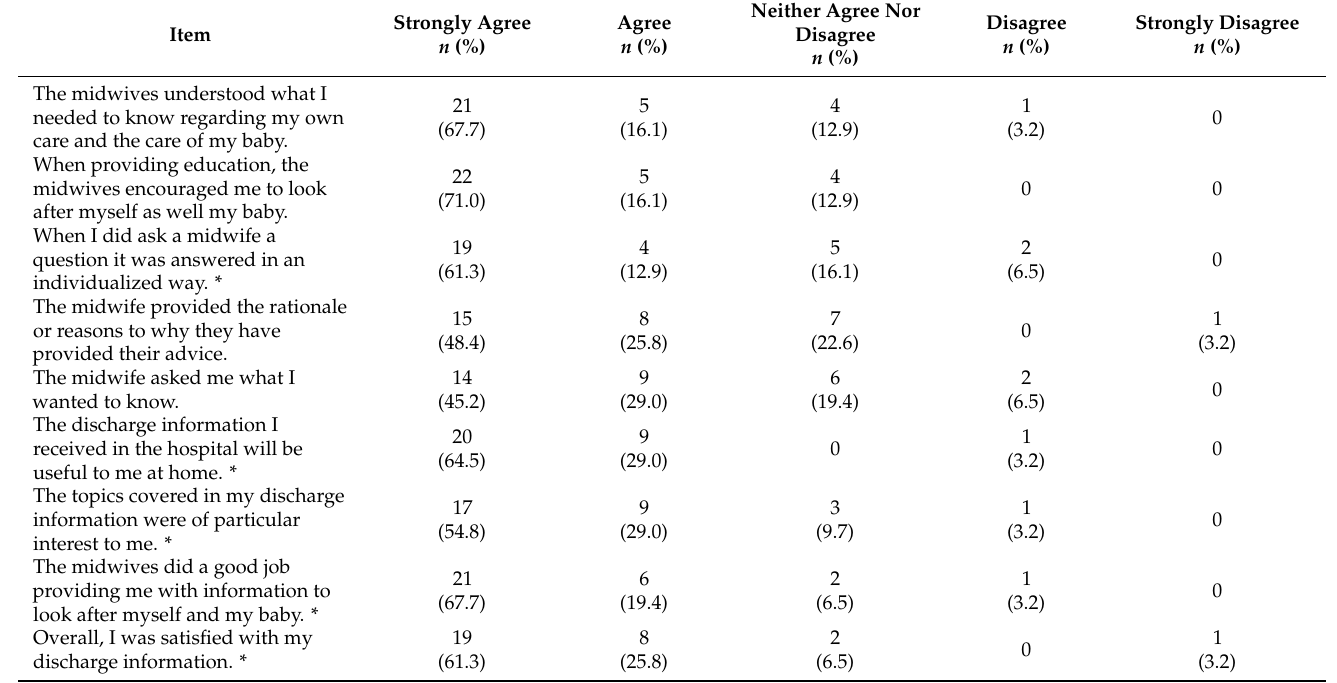
Table 1. Survey responses to discharge information